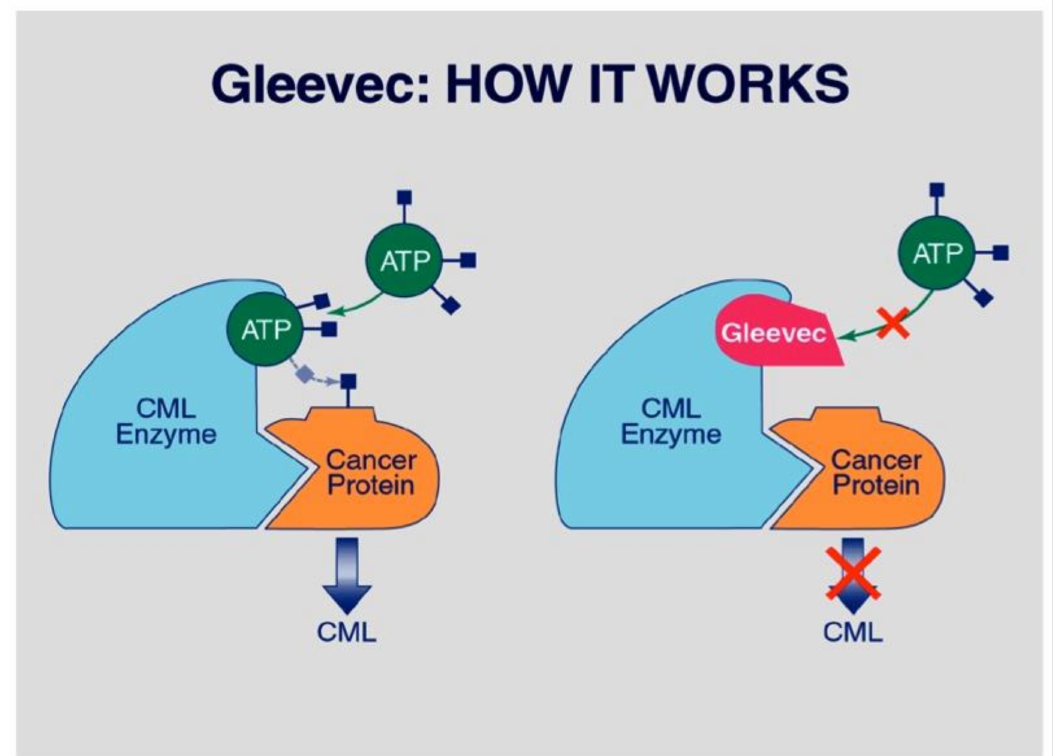
Figure 2. Mode of action of imatinib (Gleevec) in CML: Occupation of the tyrosine kinase pocket of ABL (CML enzyme) impedes use of ATP to phosphorylate its substrate and thereby inhibits oncogenesis. From Goodman, S.N.; Gerson, J. Mechanistic Evidence in Evidence-Based Medicine: A Conceptual Framework Internet. Rockville (MD): Agency for Healthcare Research and Quality (US); 2013 Jun. Results and Case Studies. Available online: https://www.ncbi.nlm.nih. gov/books/NBK154588 (accessed on 15 July